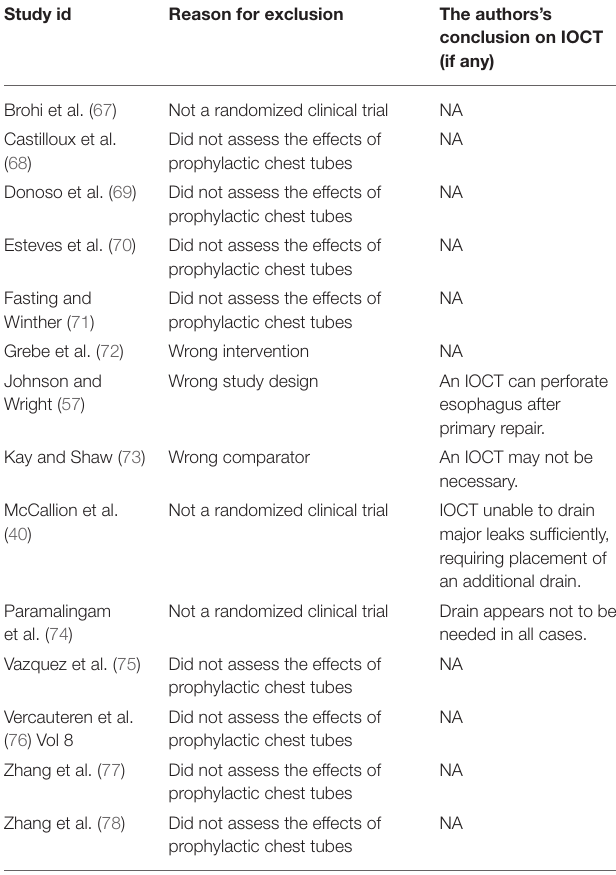
TABLE 1 | Table of excluded